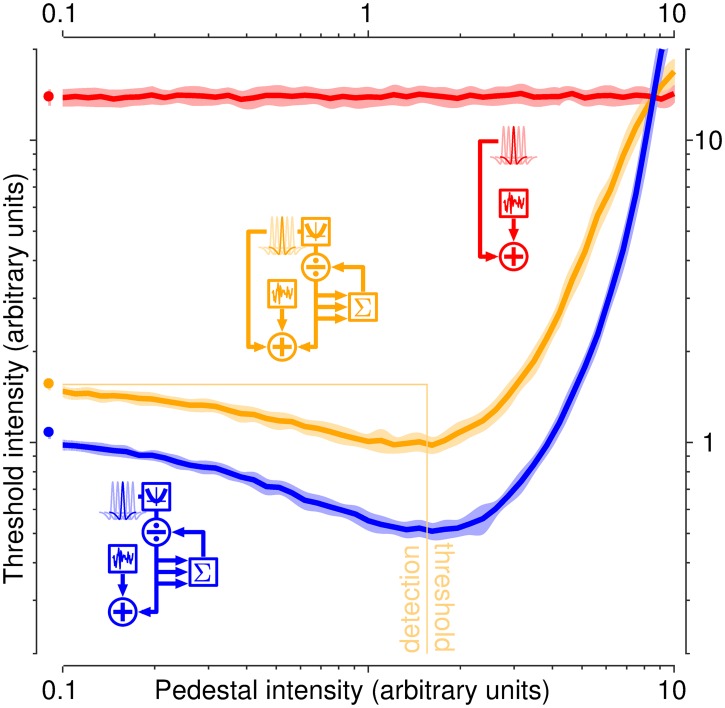
Hybrid model captures the dipper effect.Results from simulations of a contrast discrimination task in the presence of added pedestal contrast (see Methods). Hybrid model (orange) produces the typical threshold-vs-contrast (TvC) dipper function with trough in the vicinity of detection threshold value. The linear branch (red) on its own fails to reproduce the classic dipper characteristic; the nonlinear branch (blue) produces a dipper, albeit slightly shifted to the right of its detection threshold and with an exceedingly steep ‘handle’. Shaded regions show ±1 SD across simulations.